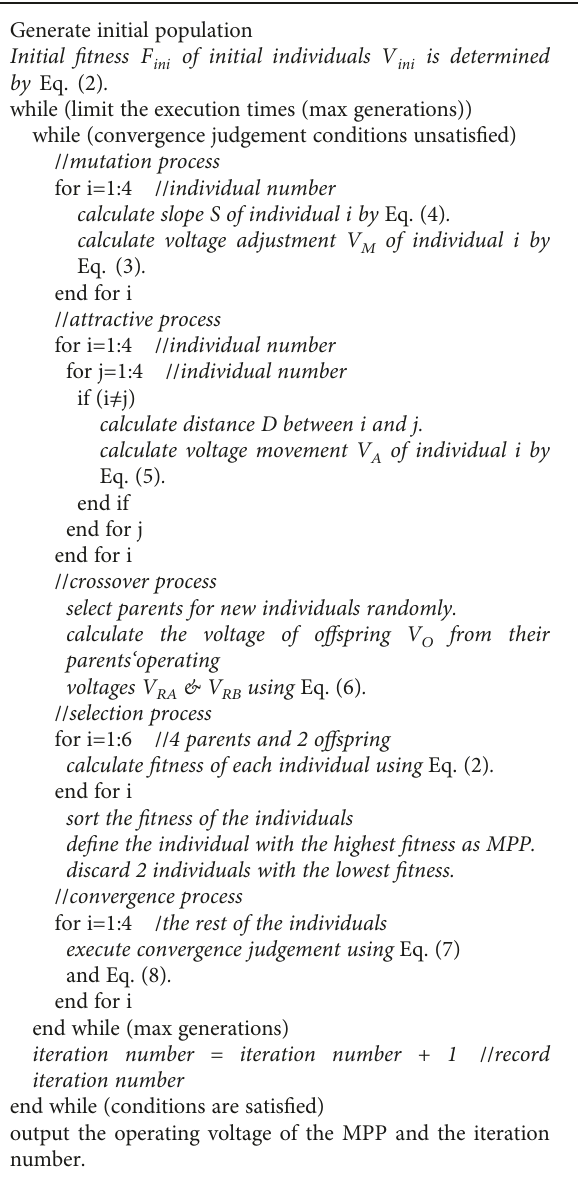
Pseudocode 1: MATLAB pseudocode of the proposed